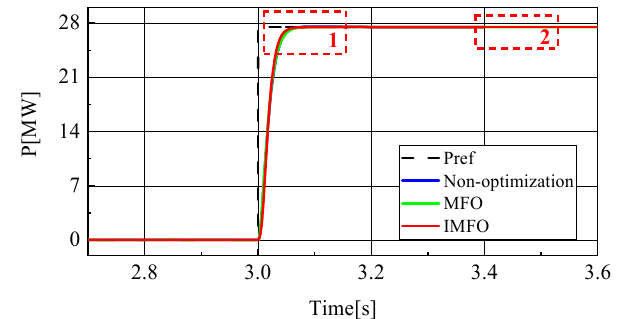
Figure 10. Active power waveform.